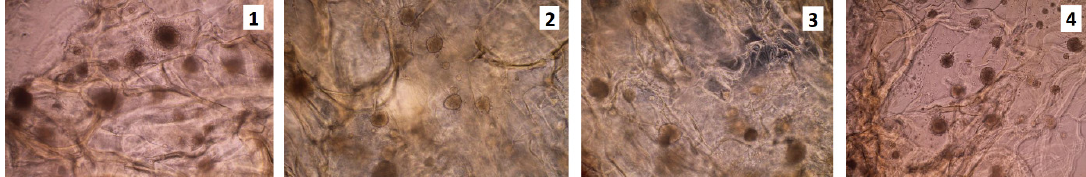
Figure 7. Antioxidant properties study.